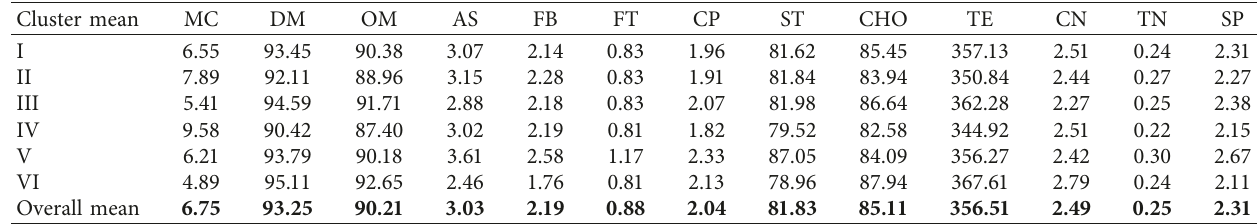
Table 8: Cluster means for 13 biochemical characters of cassava accession grown at southwest Ethiopia. Cluster